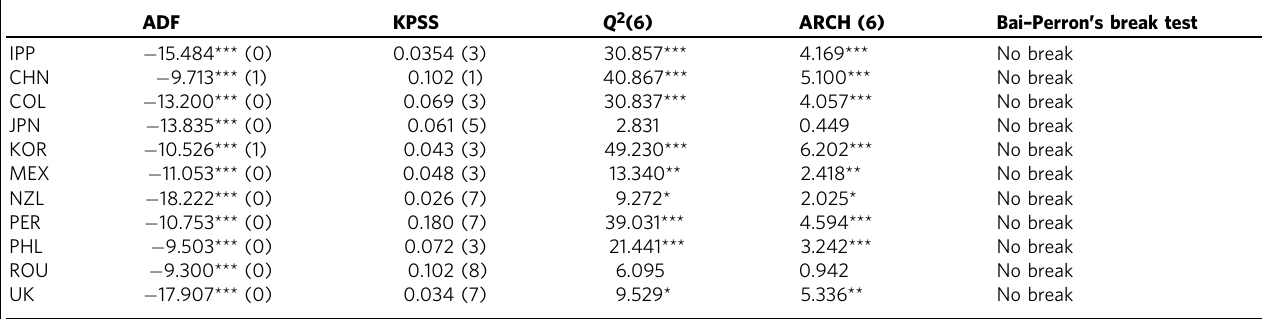
Table 2 Preliminary